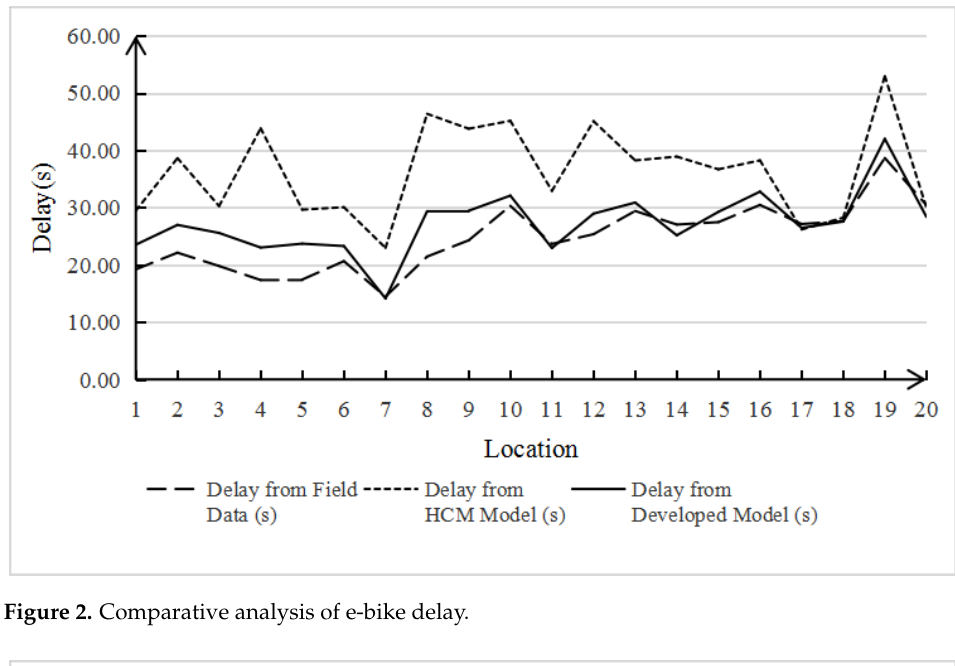
Figure 2. Comparative analysis of e-bike delay.